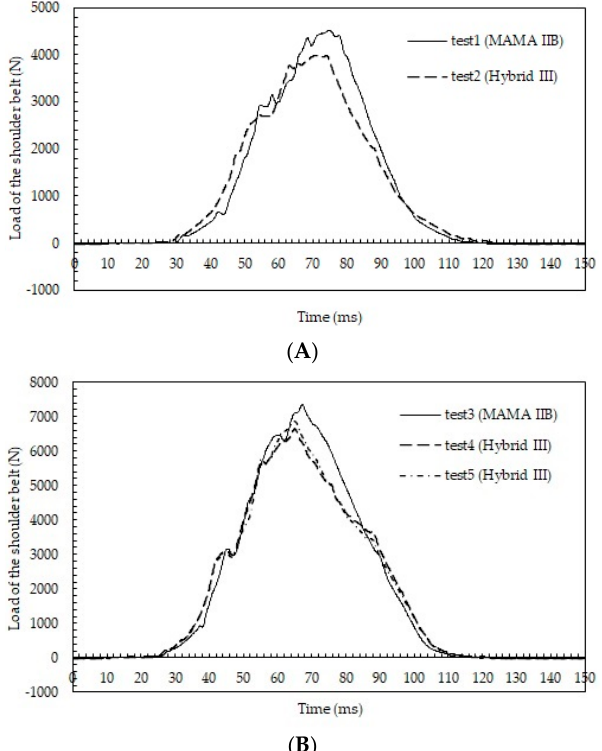
Figure 4. ( A ) Time courses of the loads of the lap belt in tests 1 and 2; ( B ) time courses of the loads of the lap belt in tests 3–5.